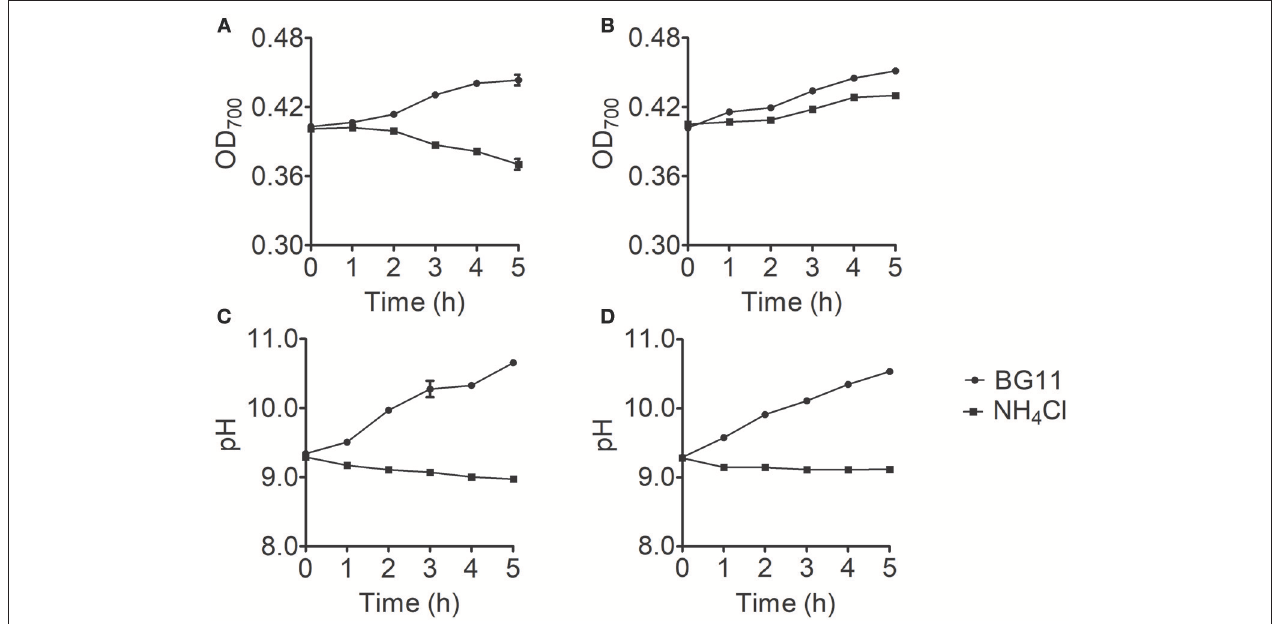
FIGURE 4 | Growth and pH changes in Chlorella strain FACHB-1216 and FACHB-1563 cultured in BG11 (circles) and 1g L − 1 NH 4 Cl (squares). (A,B) Represent the growth of Chlorella strain FACHB-1216 and FACHB-1563, respectively; (C,D) Represent pH changes in Chlorella strain FACHB-1216 and FACHB-1563, respectively.